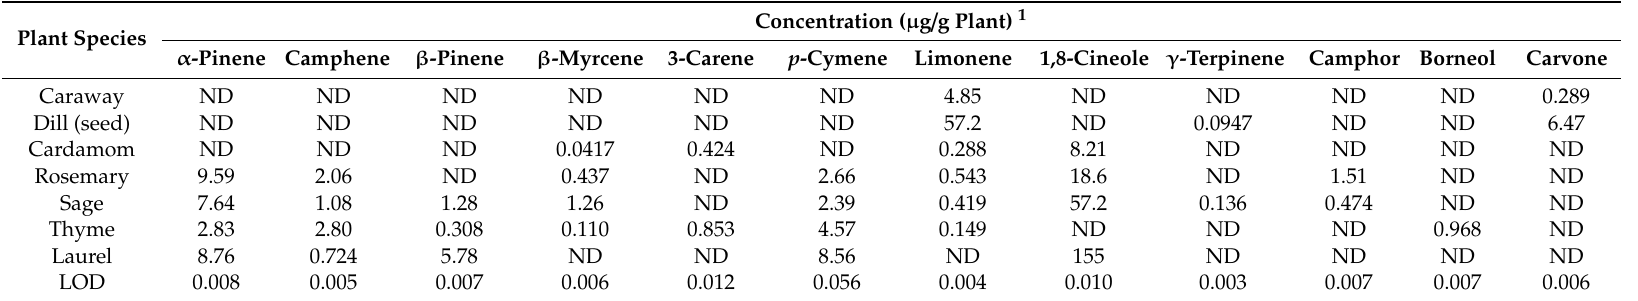
Table 2. Volatile compounds identified from the spices and herbs with high growth inhibitory activities.